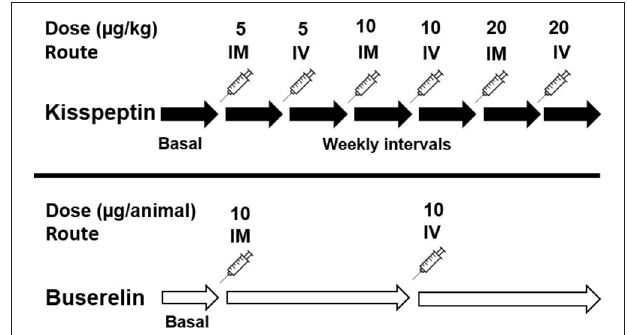
FIGURE 1 | Schematic representation of methodology for dose-response study. Following initial basal observation of follicular dynamics for a week, kisspeptin was administered at three different doses at two routes (i.e., IM or IV) at weekly intervals approximately. A minimum of 4 ultrasound observations of follicular dynamics were carried out on alternate days between two injections, as depicted by the solid black arrow. Buserelin was administered at a single dose rate recommended by the manufacturer via two routes (i.e., IM or IV) at triweekly intervals approximately, as depicted by the longer white